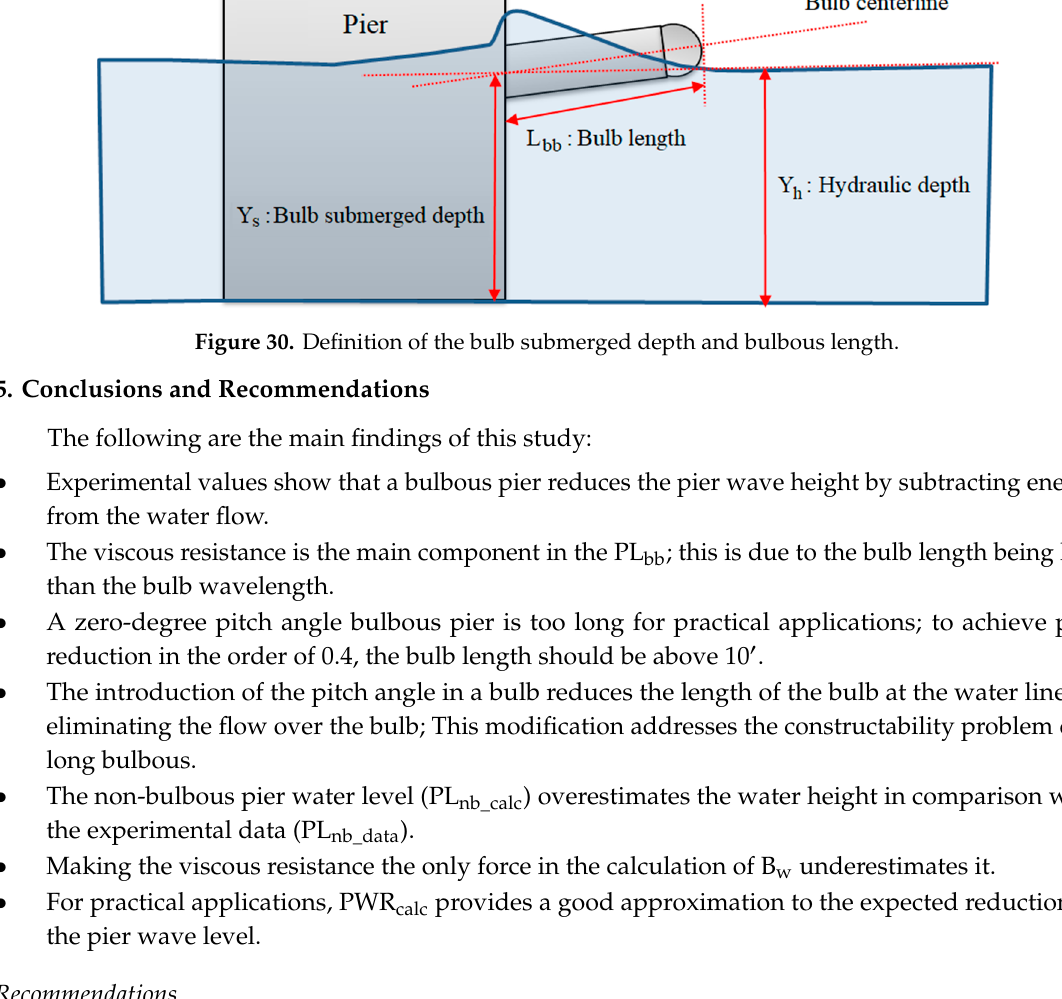
Figure 29. Proposed PWR approximation using normalized bulb length, and 5 ˚ pitch angle.